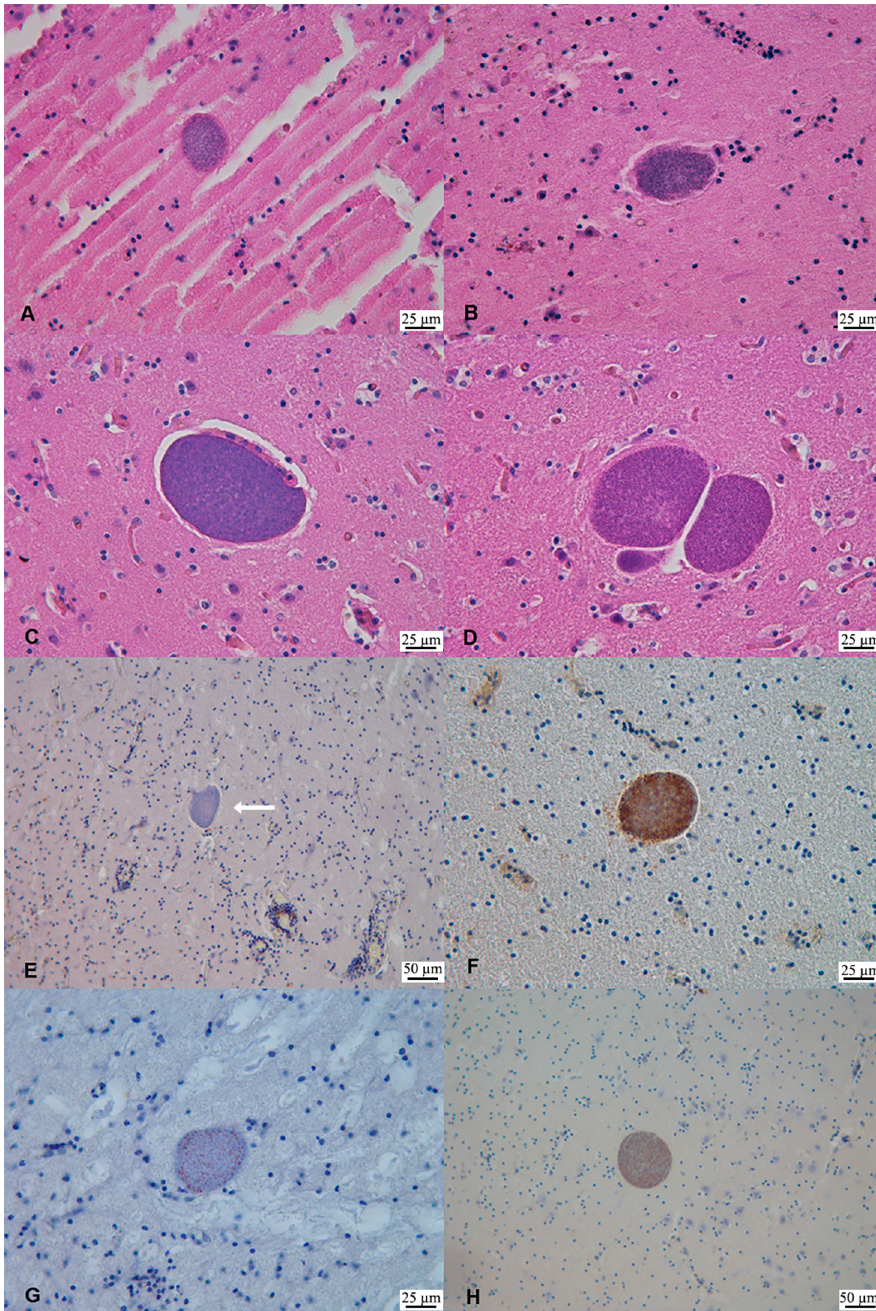
Figure 2. Sarcocystis -like tissue cysts in the brain of striped dolphins ( Stenella coeruleoalba ) SD1 and SD2 from Liguria, Italy. ( A ) Parietal cortex (SD1). Protozoan tissue cyst measuring 70 × 50 μ m. H&E. ( B ) Occipital cortex (SD1). Protozoan tissue cyst measuring 44.6 × 58.1 μ m. H&E. ( C ) Frontal cortex (SD2). Protozoan tissue cyst measuring 72.83 × 116.34 μ m. H&E. ( D ) Basal ganglia (SD2). Protozoan tissue cysts measuring (left-right reading) 110 × 119.3 μ m, 40 × 19.8 μ m and 50 × 99.1 μ m. H&E. ( E ) Mesencephalon (SD1). Negative immunostaining of a protozoan tissue cyst (arrow). Monoclonal Ab anti- S. neurona . ( F ) Cerebellum (SD1). Positive labeling of Sarcocystis -like tissue cyst. Polyclonal Ab anti- S. falcatula. ( G ) Mesencephalon (SD1). Positive labeling of a protozoan tissue cyst bradyzoites. Polyclonal Ab anti- S. neurona. ( H ) Parietal cortex (SD2). Positive immunostaining of a protozoan tissue cyst bradyzoites. Polyclonal Ab anti- S. neurona. Sarcocystis -like tissue cysts in the brains of both SD1 and SD2 stained immunoposi- tive with the anti- S. neurona polyclonal antiserum. Similar results were obtained with the